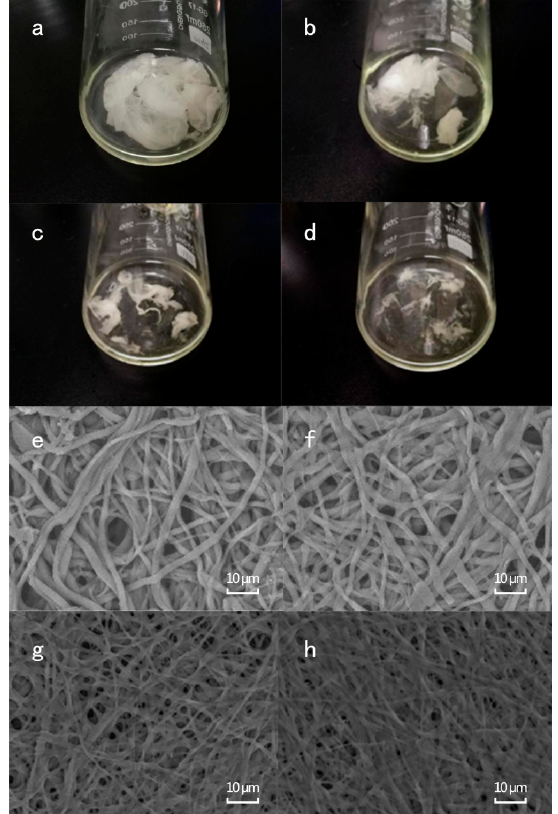
Figure 5. Visual image of alkaline protease and Na 2 SO 3 combination at di ff erent times: ( a ) 0.5 h; ( b ) 1 h; ( c ) 1.5 h; ( d ) 2 h. ESM images of di ff erent treatment groups: ( e ) sodium sulfite treatment alone for 4 h; ( f ) alkaline protease alone for 4 h; ( g , h ) sodium sulfite + alkaline protease treatment (( g ) 1 h, ( h ) 1.5